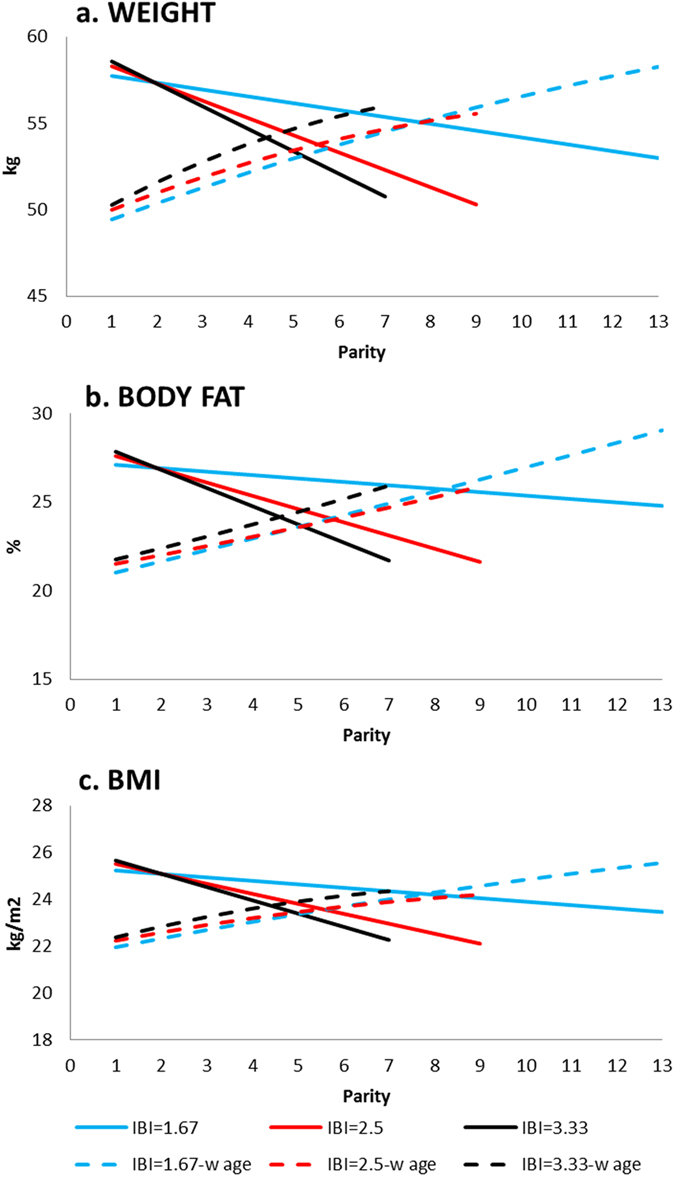
Effects of parity and inter-birth interval on women’s nutritional status for women aged 15–44.Panels include (a) weight, (b) body fat percentage, and (c) BMI. Interbirth interval (IBI) defined as the mean ± 1 SD (2.50 ± 0.83 years). Solid lines convey predicted marginal effect of parity and IBI, holding all other variables at sample averages, including age. Dashed lines use average age at first birth for parity = 1, and then add the IBI to each age in the regression models given in Table 3. Average age at first and last birth is 18 and 38, respectively.